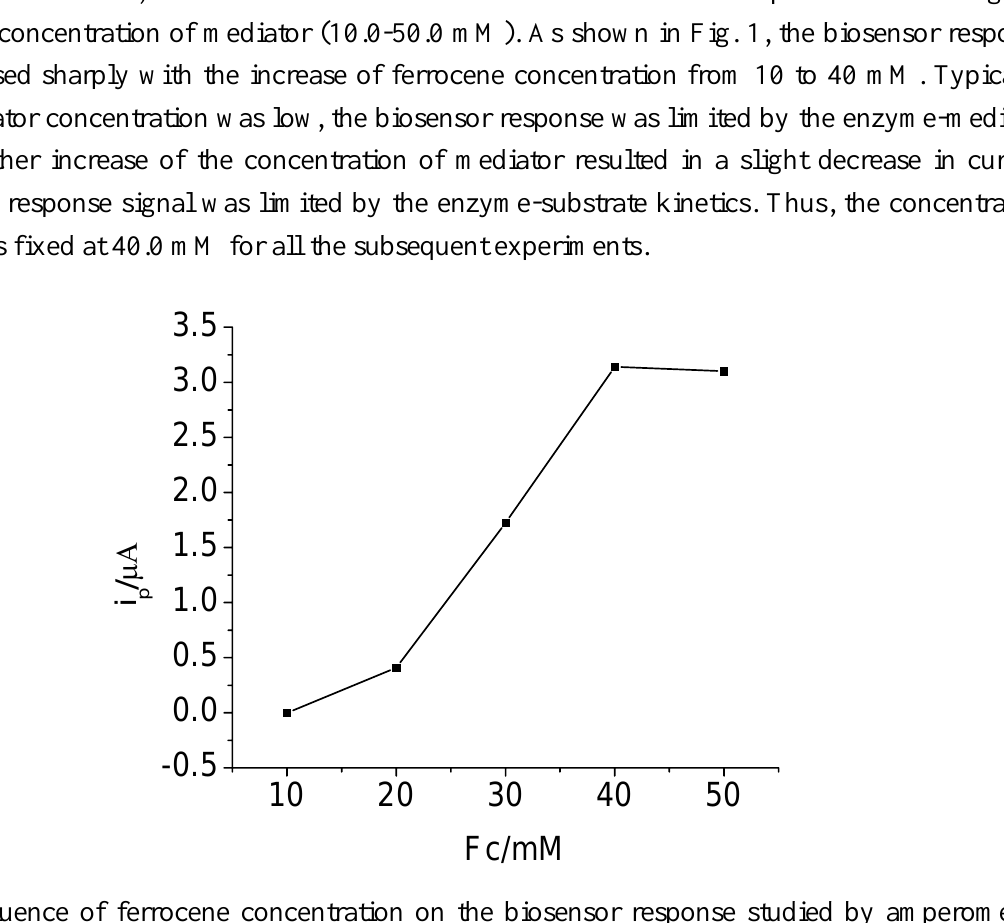
O in 10.0 mL 0.02 M phosphate buffer solution (pH 2 2